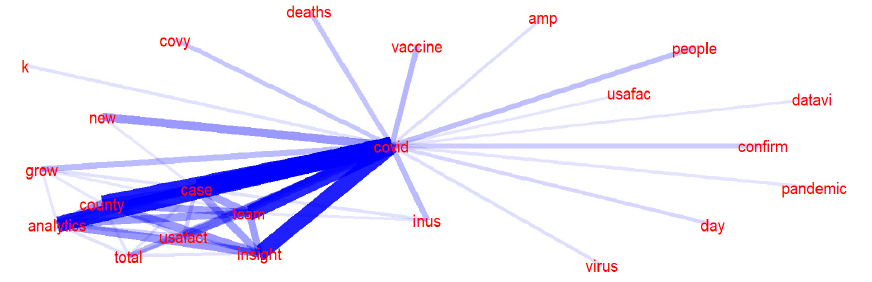
Figure 6. Word collocation of tweets posted by social bots.